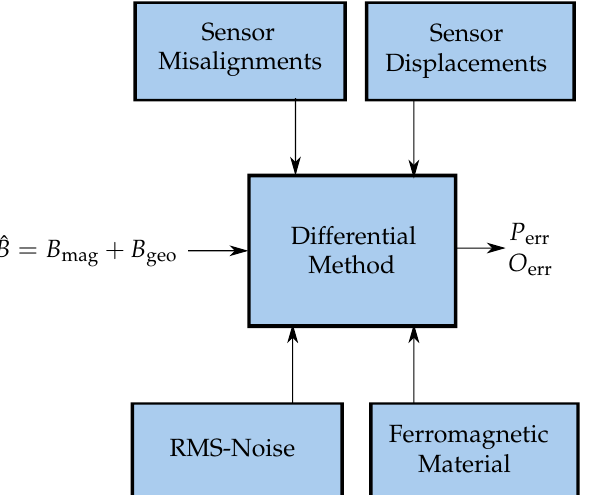
Figure 7. Block-diagram of various non-idealities influencing the proposed differential localization setup.